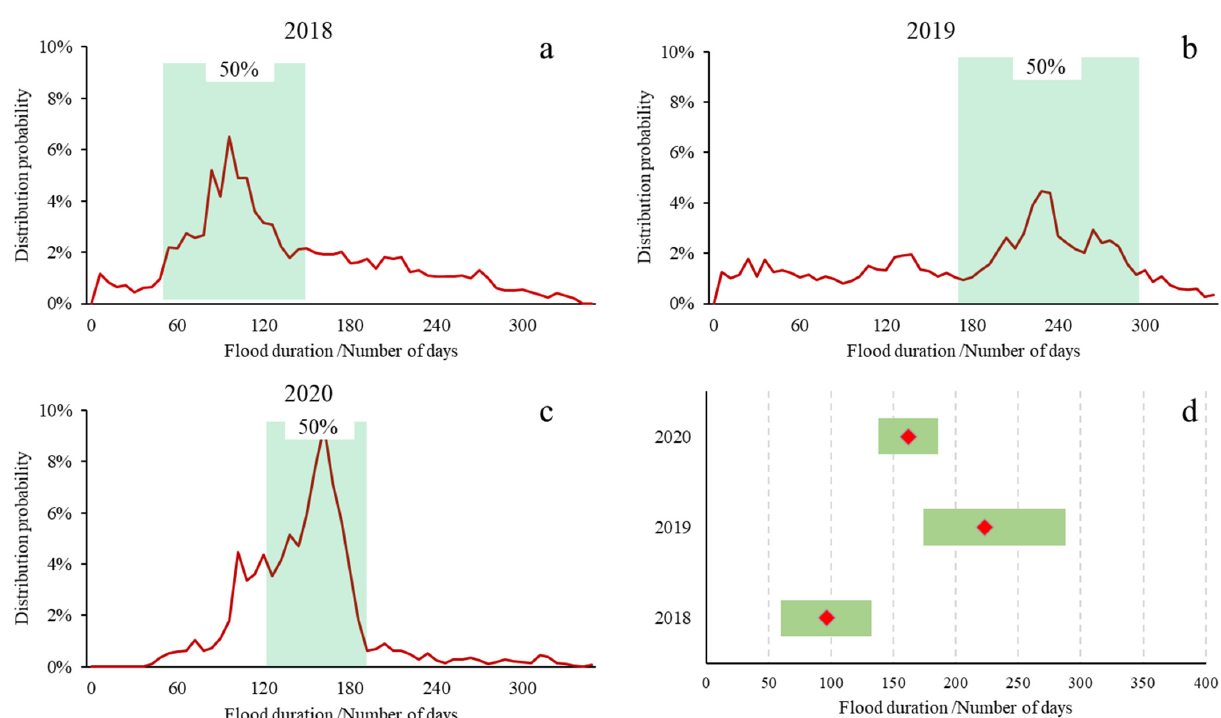
Figure 6. ( a – c ) The goose distribution probability and their corresponding flood duration at Poyang Lake from 2018 to 2020. ( d ) The optimal threshold of flood duration and the highest distribution probability for 2018, 2019, and 2020 (Green colored part: the optimal threshold of the flood duration index. Red square symbol: the highest distribution probability).